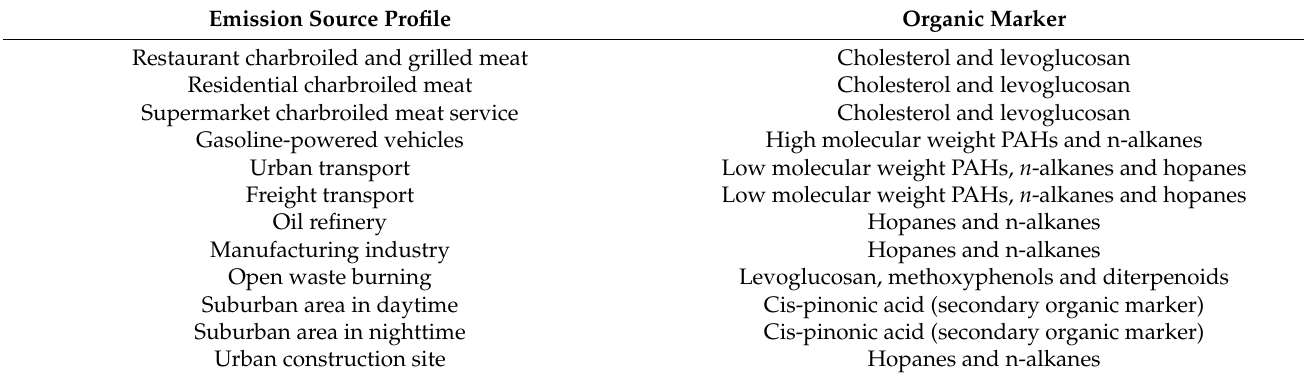
Table 3. Key organic markers for every source